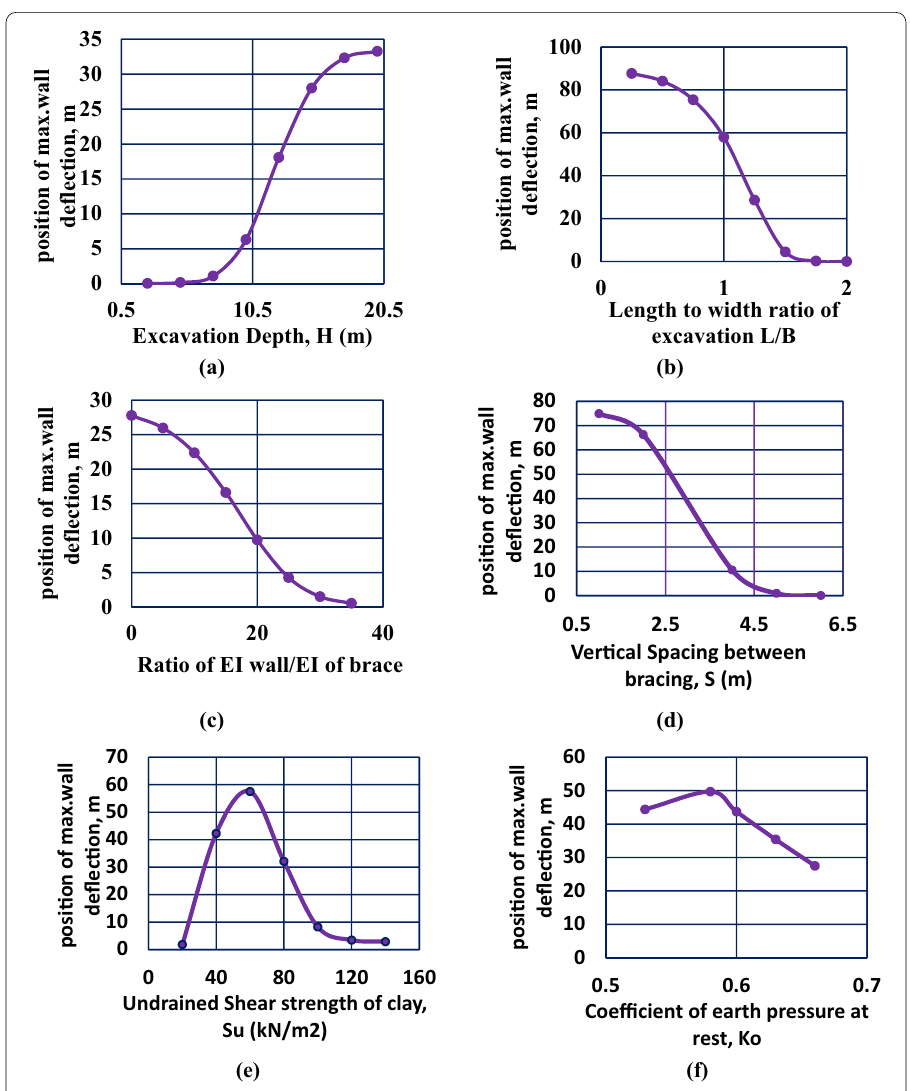
Fig. 10 Result of a parametric study of (ANN) model for the position of max. excavation under different, a excavation depth, (H), b length to width ratio, (L/B), c ratio of EI wall/EI of bracing, d vertical distance of bracing between spacing, e undrained shear strength, Su, f coefficient of lateral earth pressure at rest